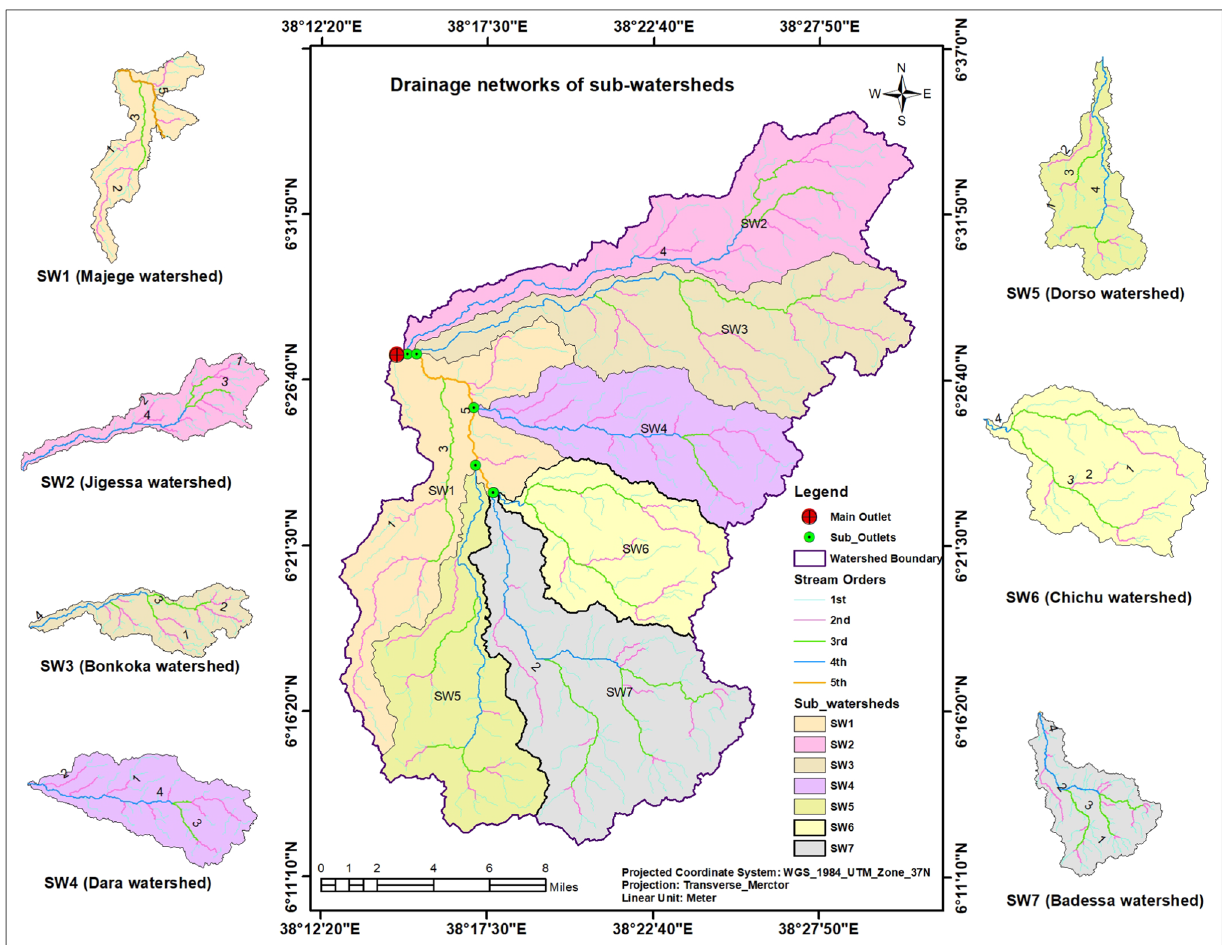
Fig. 3 Map of sub-watersheds and drainage